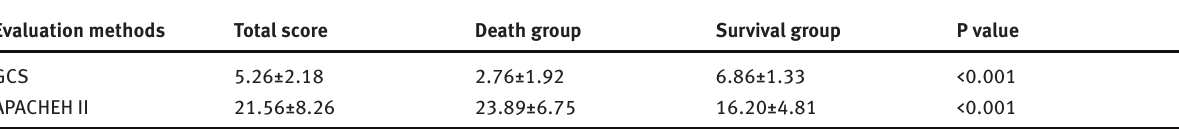
Table 1: Comparison between the APACHE II and GCS of survivors and